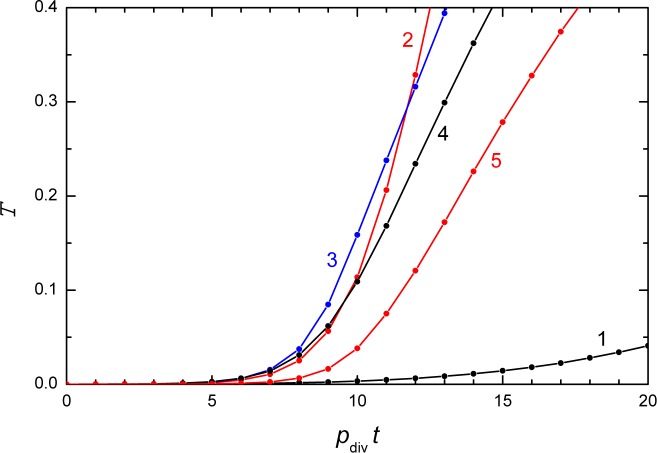
Kinetics of cell growth in the Monte Carlo simulations.Lines 1–5 represent the cell growth kinetics of MC runs shown in Figs 5–9, respectively.